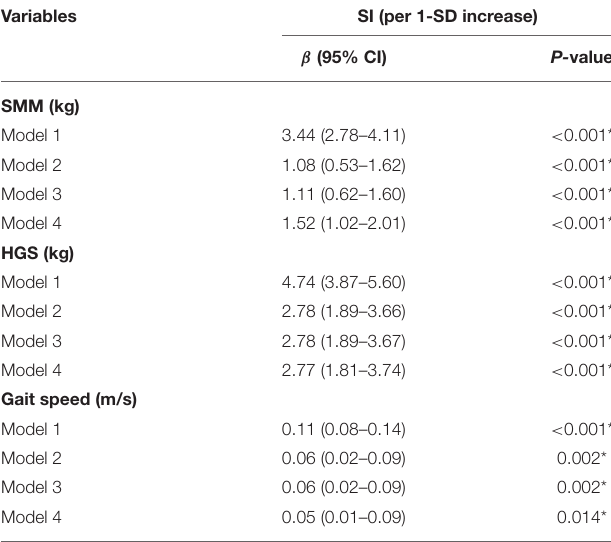
TABLE 3 | Independency of SI with SMM, HGS, and gait speed.